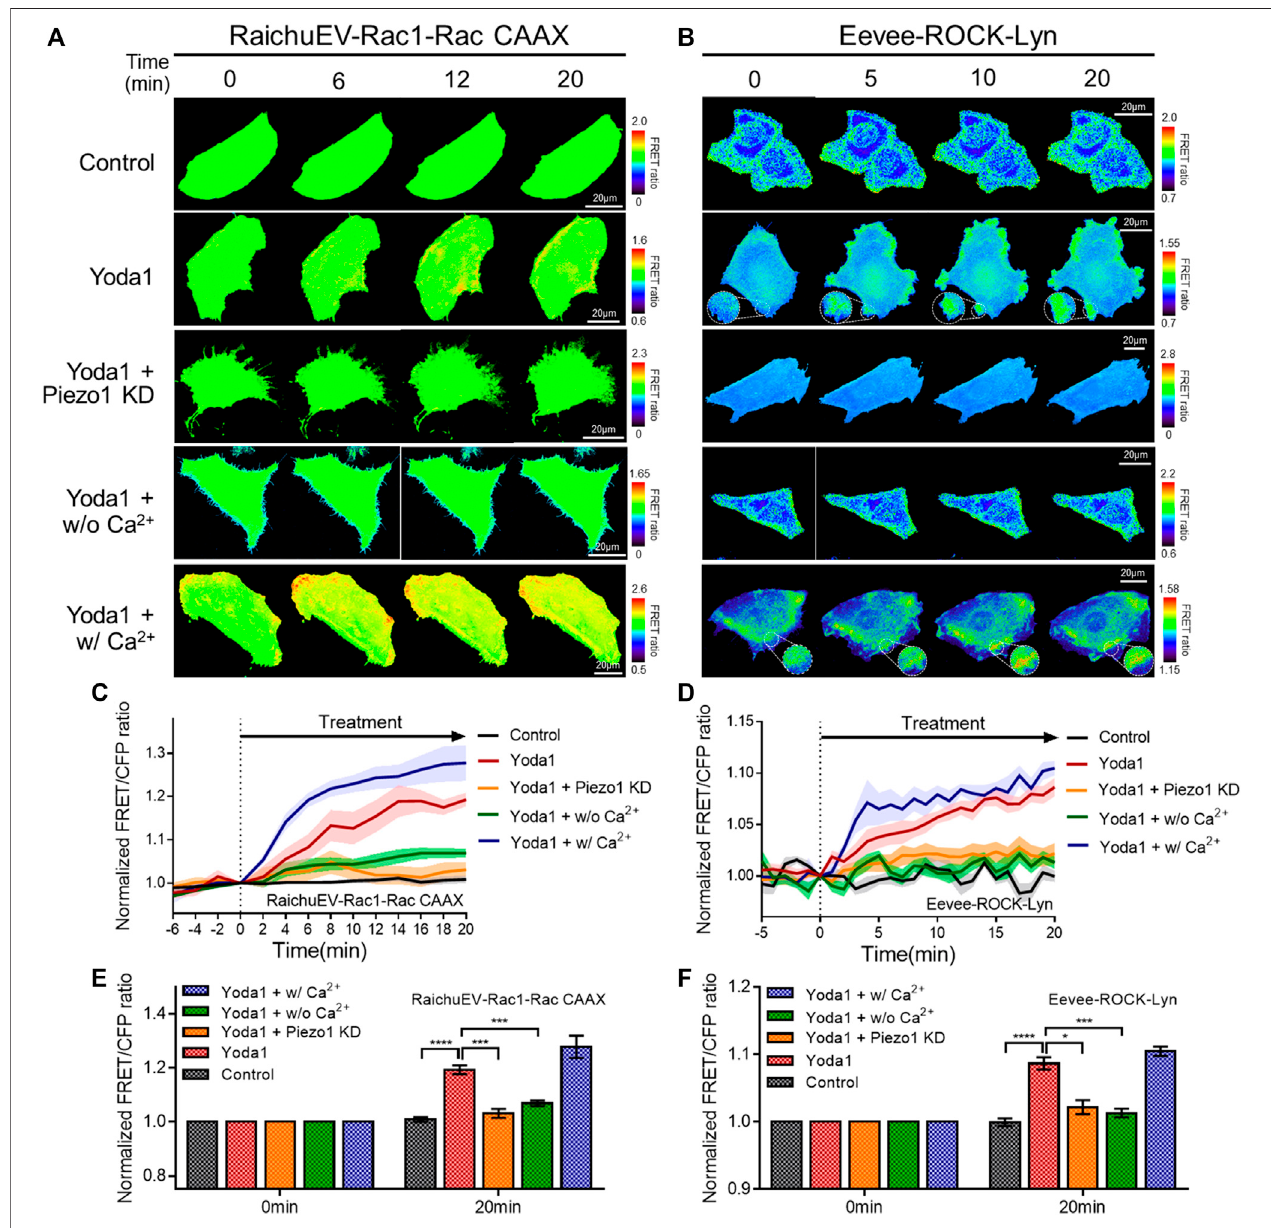
FIGURE 7 | Extracellular calcium in fl ux through Piezo1 increases Rac1 and ROCK activity. (A,B) Time-lapse FRET images of the (A) RaichuEV-Rac1-Rac CAAX and (B) Eevee-ROCK-Lyn in MCF-7 cells. The cells were exposed to control [0.2% (v/v) DMSO] and Yoda1 (1 μ M for RaichuEV-Rac1-Rac CAAX and 5 μ M for Eevee- ROCK-Lyn) dissolved in CO 2 -independent culture medium (Yoda1 group), Ca 2+ -free medium (Yoda1 + w/o Ca 2+ group), and Ca 2+ medium (Yoda1 + w/Ca 2+ group), respectively. The Yoda1 + Piezo1 KD group was incubated in a CO 2 -independent culture medium. The color scale bars represent the range of the FRET/CFP emissionratiodeterminedusingthebiosensor.Hotandcoldcolorsindicatehighandlow (A) Rac1and (B) ROCKactivity,respectively. (C,D) Thetimecoursesrepresent the average of the normalized FRET/CFP emission ratio changes of (C) RaichuEV-Rac1-Rac CAAX and (D) Eevee-ROCK-Lyn. The lines are mean values of normalized emission ratios, with diluted colors indicating the S.E.M ( n = 7). (E,F) The bar graph describes the mean values of the normalized FRET/CFP emission ratios of (E) RaichuEV-Rac1-Rac CAAX and (F) Eevee-ROCK-Lyn at the indicated times with the error bars indicating the S.E.M ( n = 7, * p < 0.05, *** p < 0.001 and **** p < 0.0001, Student ’ s t